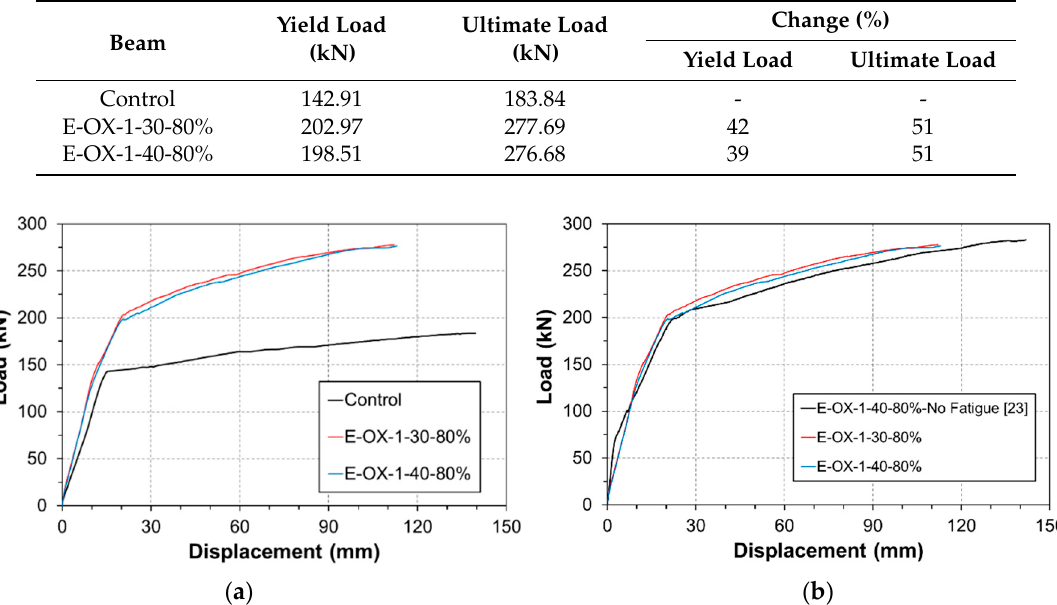
Table 4. Experimental results of NSM-strengthened RC beam (Concrete strength).